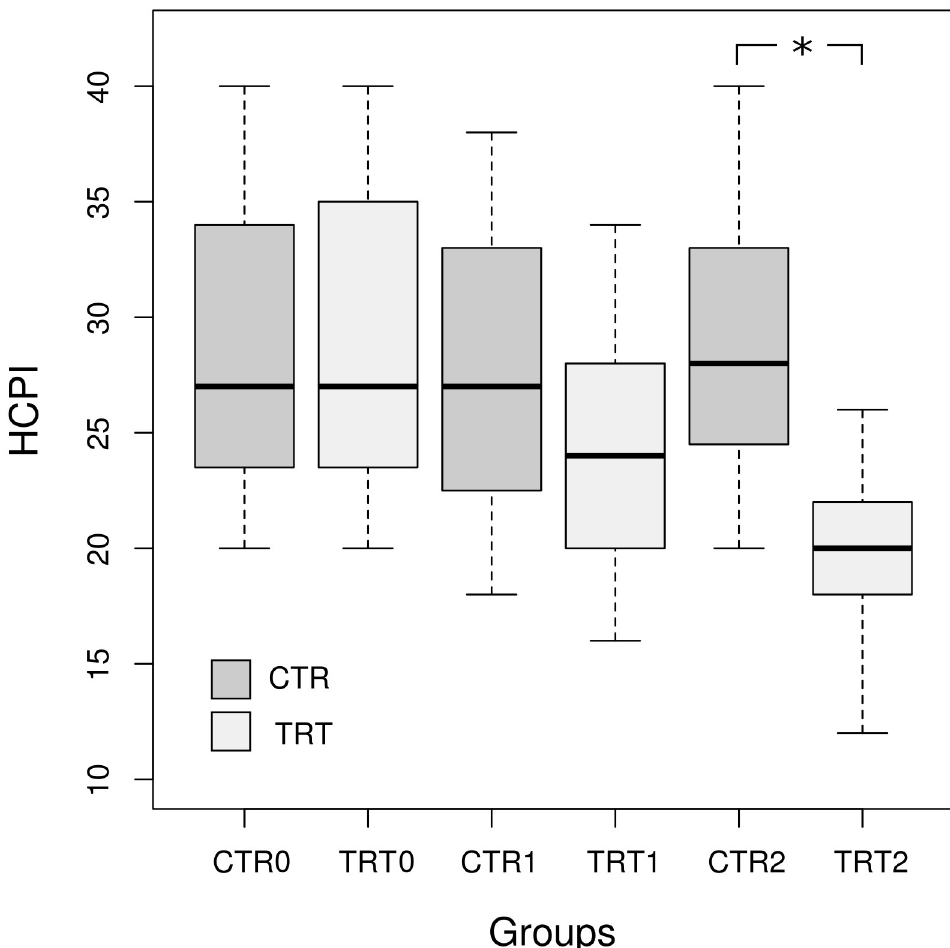
Fig 2. Comparison of HCPI scores between CRT and TRT groups at three time points (T0, T1, T2), � p < 0.05, Mann-Whitney U test.